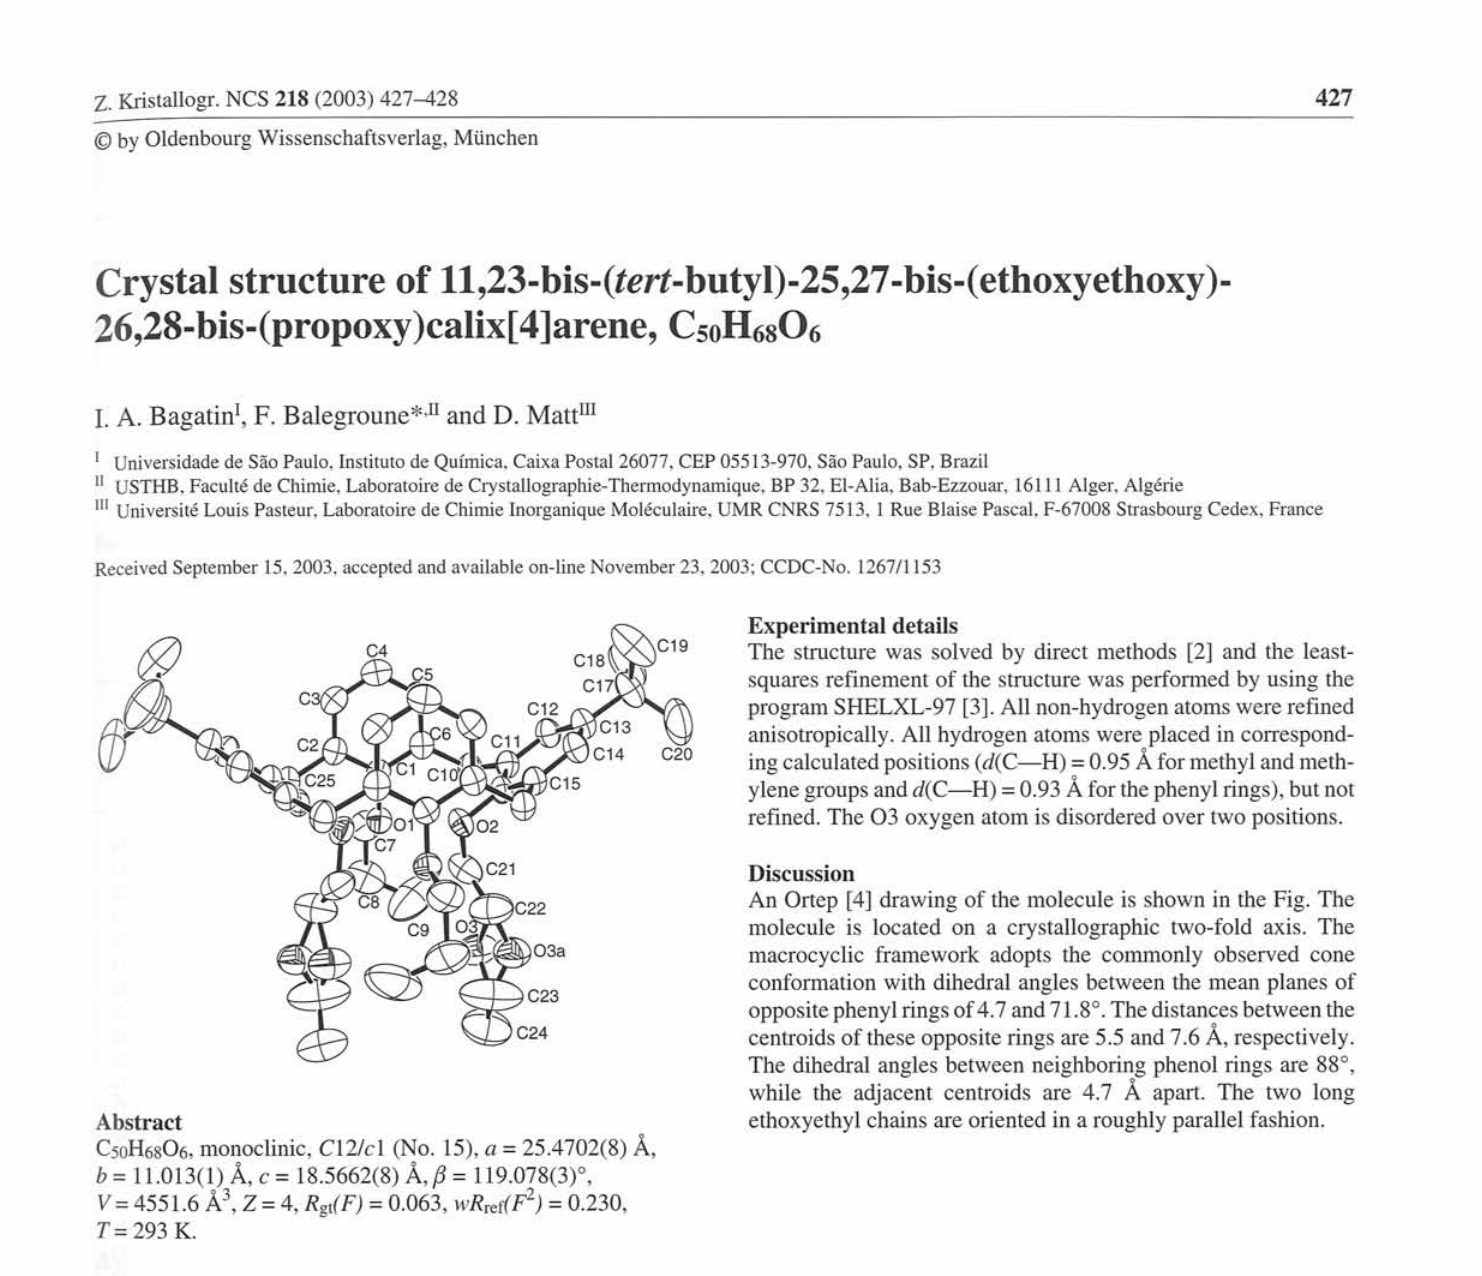
Table 1. Data collection and